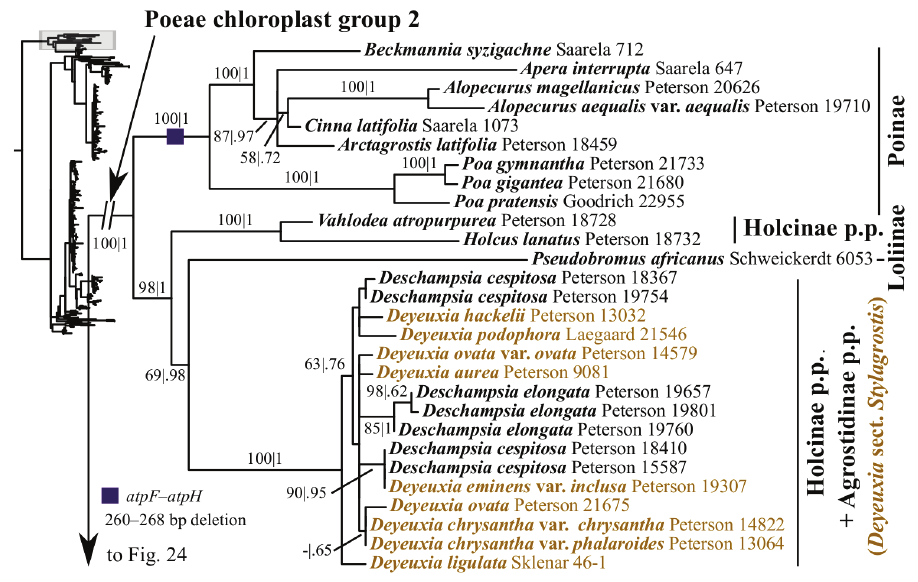
Figure 19. A portion (Agrostidinae p.p., Holcinae, Loliinae and Poinae) of the maximum likelihood phylogram inferred from combined plastid data ( atpF–atpH , psbK–psbI , psbA–rps19–trnH , matK , trnL– trnF ). ML bootstrap support (left) and BI poster probabilities (right) are recorded along branches. No support is shown for branches with bootstrap support <50% and posterior probability <.5. The shaded area of the smaller tree on the left indicates the location in the overall tree of the portion shown. Slashes (//) identify a branch shortened for presentation. An indel in atpF–atpH is mapped onto the